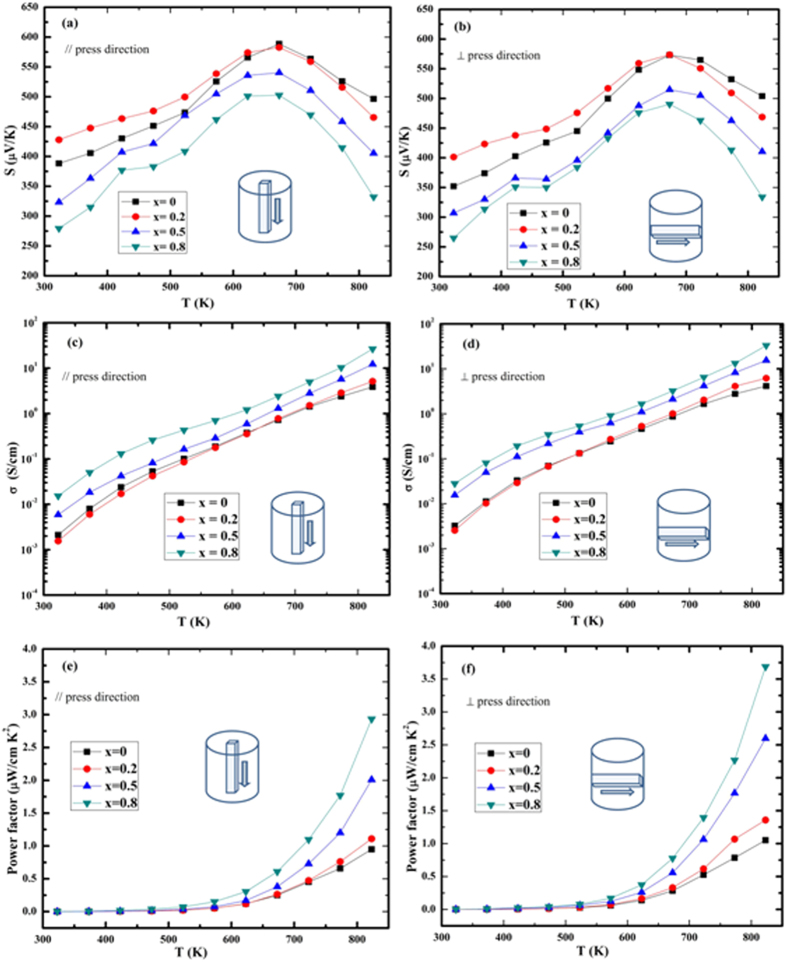
Temperature dependence of the (a,b) Seebeck coefficient, (c,d) electrical conductivity and (e,f) power factor of the SnS1−xSex (x = 0, 0.2, 0.5, 0.8) solid solutions (a,c,e) along and (b,d,f) perpendicular to the SPS-pressurizing direction.